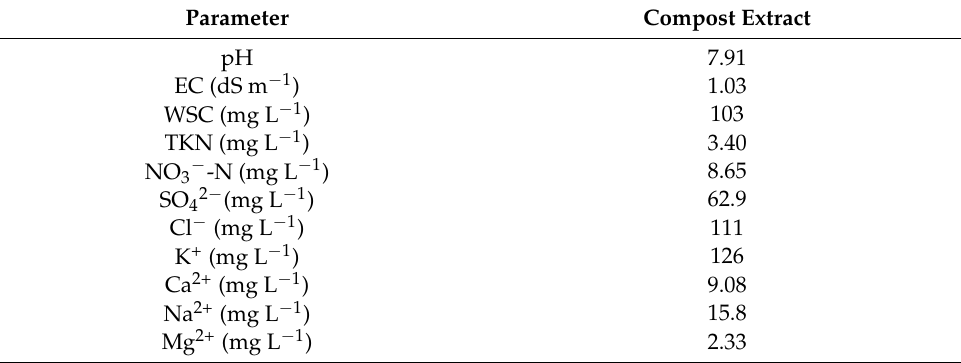
Table 1. Physico-chemical and chemical characteristics of compost